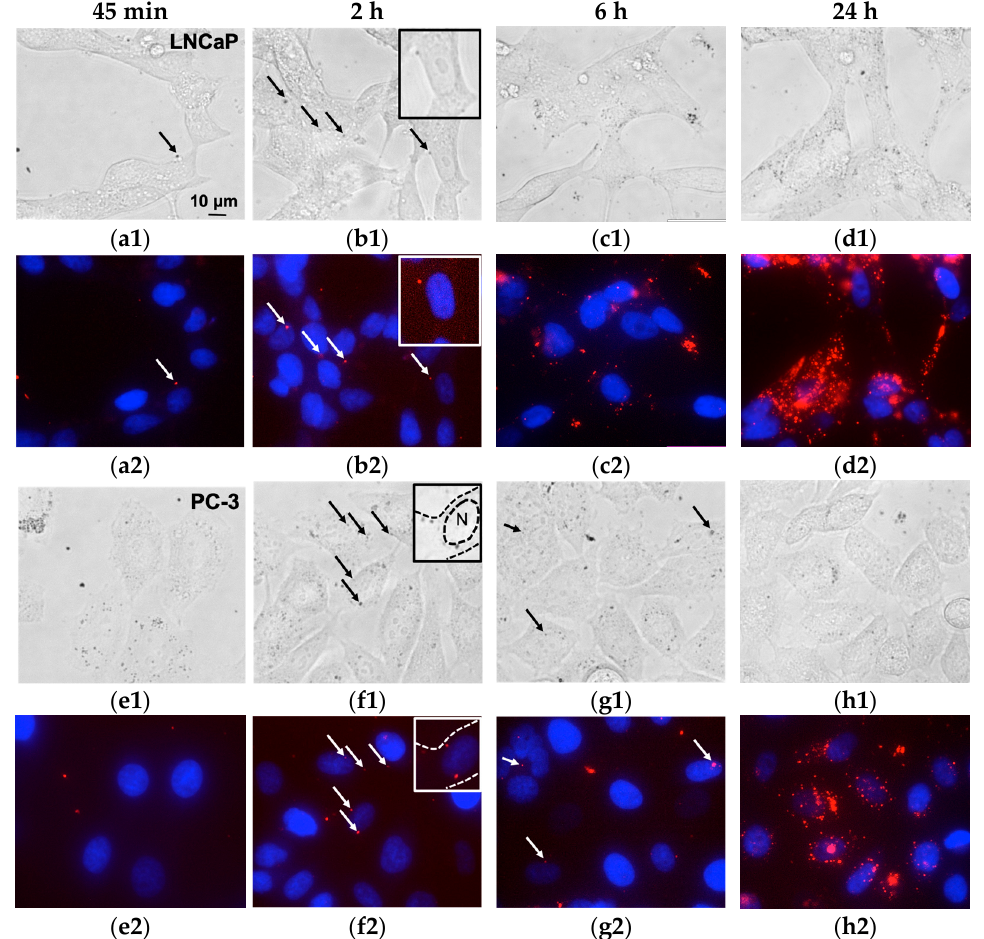
Figure 3. Dynamics of magnetite–gold dumbbell nanoparticles accumulation in cells. ( a – d ) MNP interaction with LNCaP cells after 45 min–24 h of co-incubation; ( e – h ) MNP interaction with PC-3 cells after 45 min–24 h of co-incubation. ( a1 – d1 , e1 – h1 ) Representative phase-contrast micrographs; ( a2 – d2 , e2 – h2 ) corresponding fluorescent micrographs: blue—cell nuclei stained with DAPI; red—MNPs labeled with Cy5. Arrows show some internalized MNPs. Dotted lines show the cell boundaries. Abbreviation: N—nucleus.